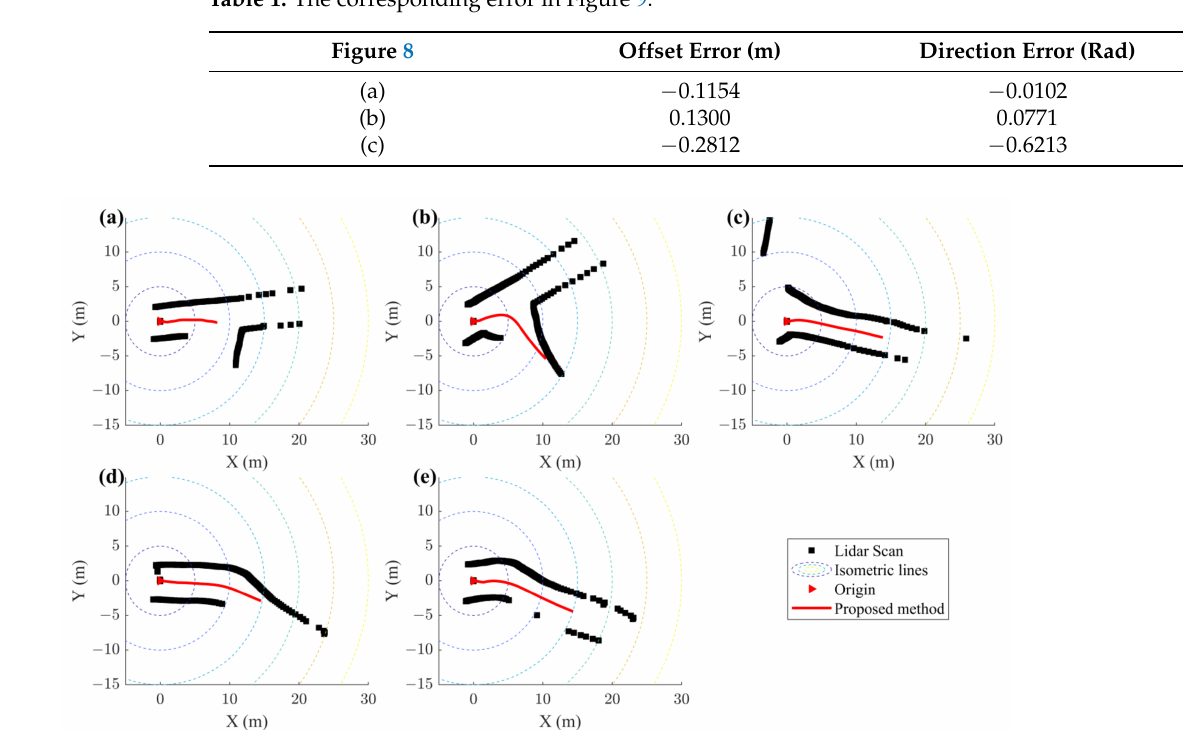
Figure 9. The local path planning of the proposed method for dataset 1 in the case of turning left, in which the red lines in ( a – c ) are shown as the local path planning of the proposed method. Table 1. The corresponding error in Figure 9.